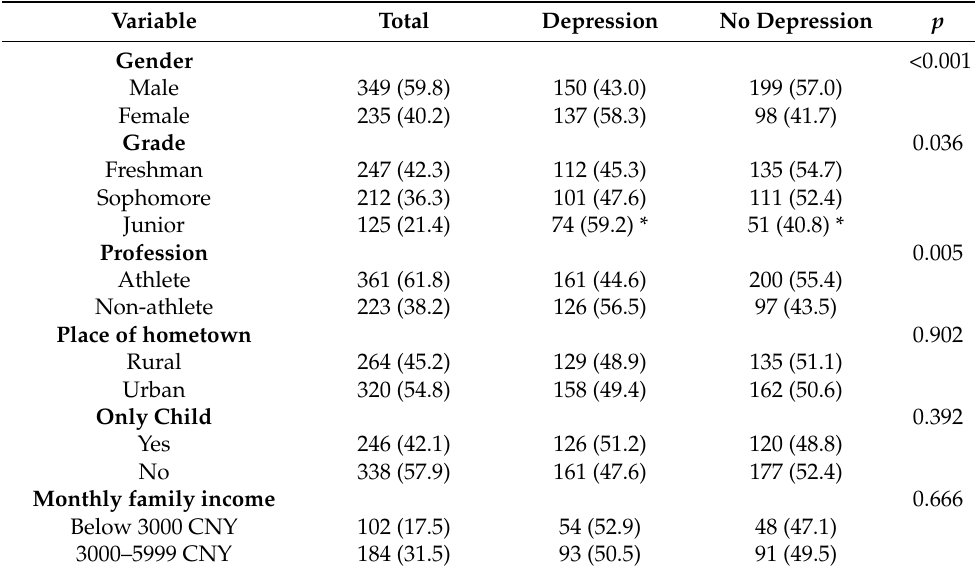
Table 1. Characteristics of participants by depression, n